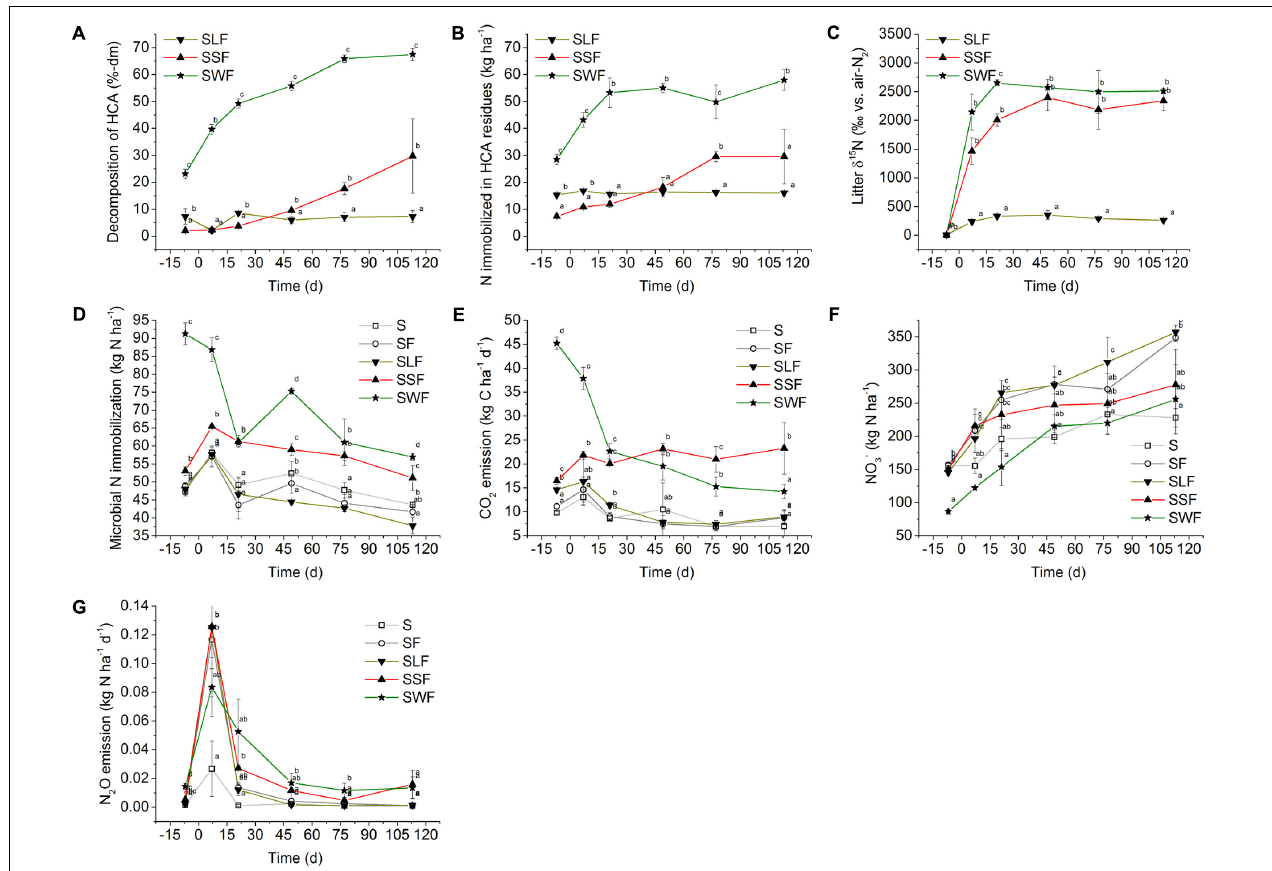
FIGURE 2 | (A) HCA decomposition (% loss of initially applied HCA dry matter), (B) physical and/or chemical N immobilization by the remaining HCA residues in kg N ha − 1 and (C) δ 15 N values in vs. air-N 2 in soil treated with mineral N and lignin (SLF, solid triangle downward), spruce sawdust (SSF, solid triangle upward), and wheat straw (SWF, solid star symbol). (D) Microbial N immobilization (kg N ha − 1 ), (E) CO 2 emission 24 h before soil sampling in kg C ha − 1 d − 1 , (F) NO 3 − (cid:104) concentration in kg N ha − 1 , and (G) N 2 O emission in kg N ha − 1 d − 1 in soil of the control treatment (S, open square) without any fertilizer or HCA, the fertilizer control treatment (SF, open circle) with mineral N fertilizer, and the HCA treatments with mineral N fertilizer plus lignin (SLF, solid triangle downward), spruce sawdust (SSF, solid triangle upward), or wheat straw (SWF, solid star symbol). Incubation time d = 0 divides the experiment into a period before (–7 DBF) and after (7, 21, 49, 77, and 113 DAF) mineral N fertilization. Standard deviations of mean values ( n = 3) are displayed. Statistically significant differences between treatments at a certain incubation time are depicted by different lowercase letters next to the symbols ( p <